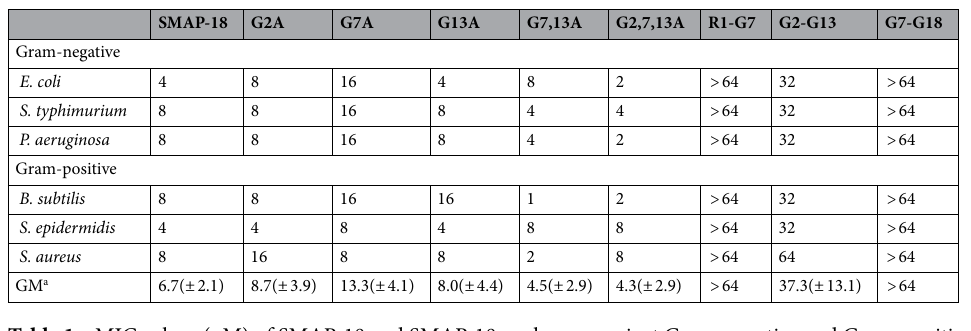
Table 1. MIC values (μM) of SMAP-18 and SMAP-18 analogues against Gram-negative and Gram-positive bacteria. a GM denotes the geometric mean of MIC values from selected bacterial strains (average value ±